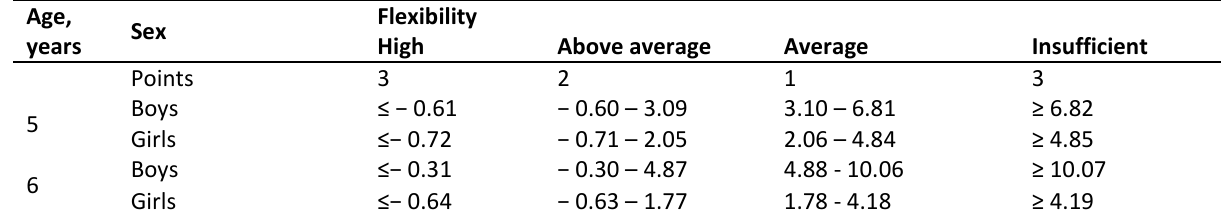
Table 2. Flexibility assessment